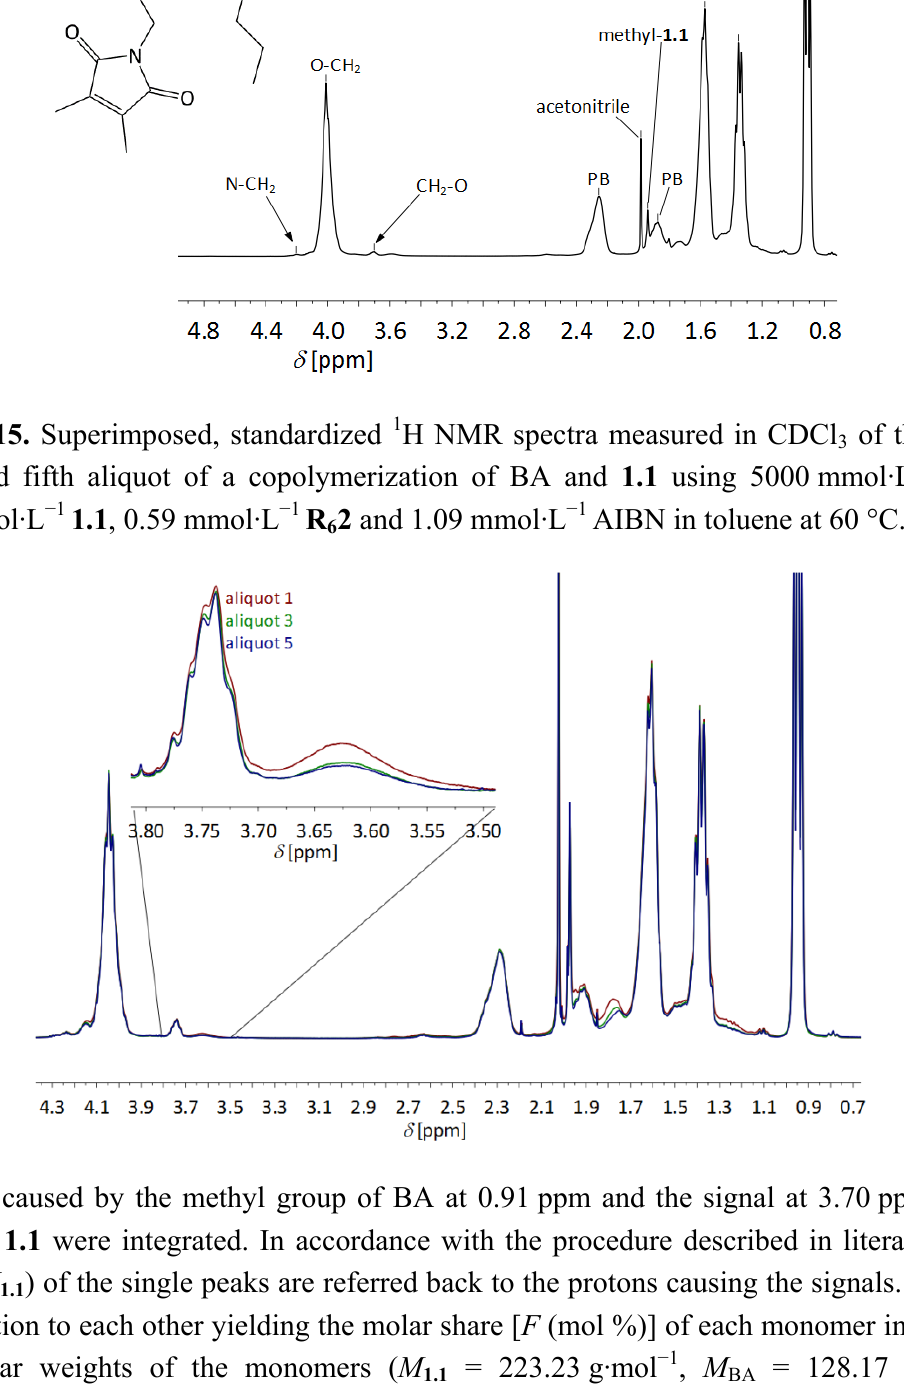
Figure 14. Extract from the 1 H NMR spectrum of p (BA- co - 1.1 ) in CDCl